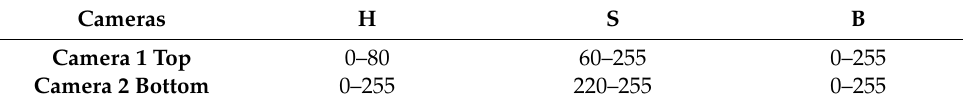
Table 1. HSB threshold values for top- and bottom-camera-position images.